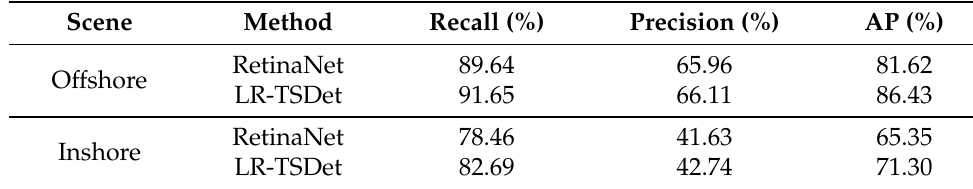
Figure 10. P-R curves of different approaches on GF1-LRSD dataset. Table 6. Comparisons of different scenarios.